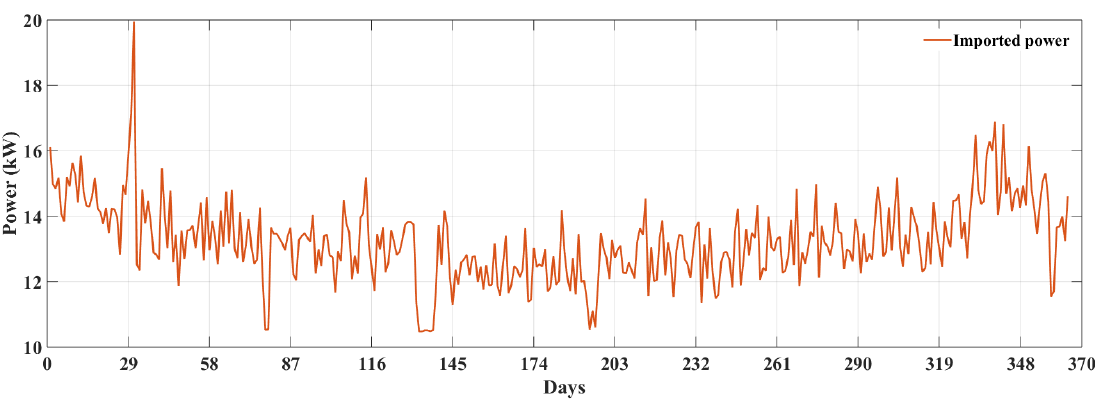
Figure 6. Power utilized without PV and battery system.